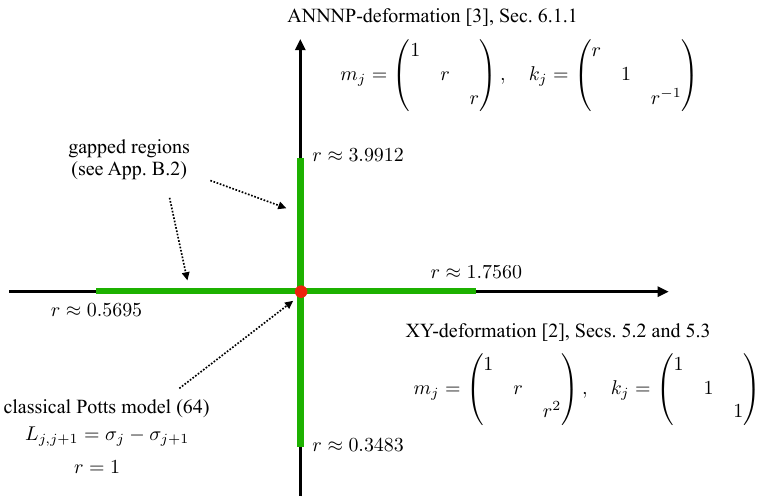
Figure 3: Schematic sketch of the relation between the two frustration-free (cid:90) models introduced by Iemini et al. [ 2 ] (see Sections 5.2 and 5.3) and Mahyaeh and Ardonne [ 3 ] (see Section 6.1.1). Both models can be obtained as deformations of the classical three-state Potts chain (red dot) using the local deformations m term k depending on the parameter r . The green lines indicate the regions in which j the systems are proven to be gapped in Appendix B.2. In particular, within this region the two models can be connected without closing the energy gap, implying that they are in the same